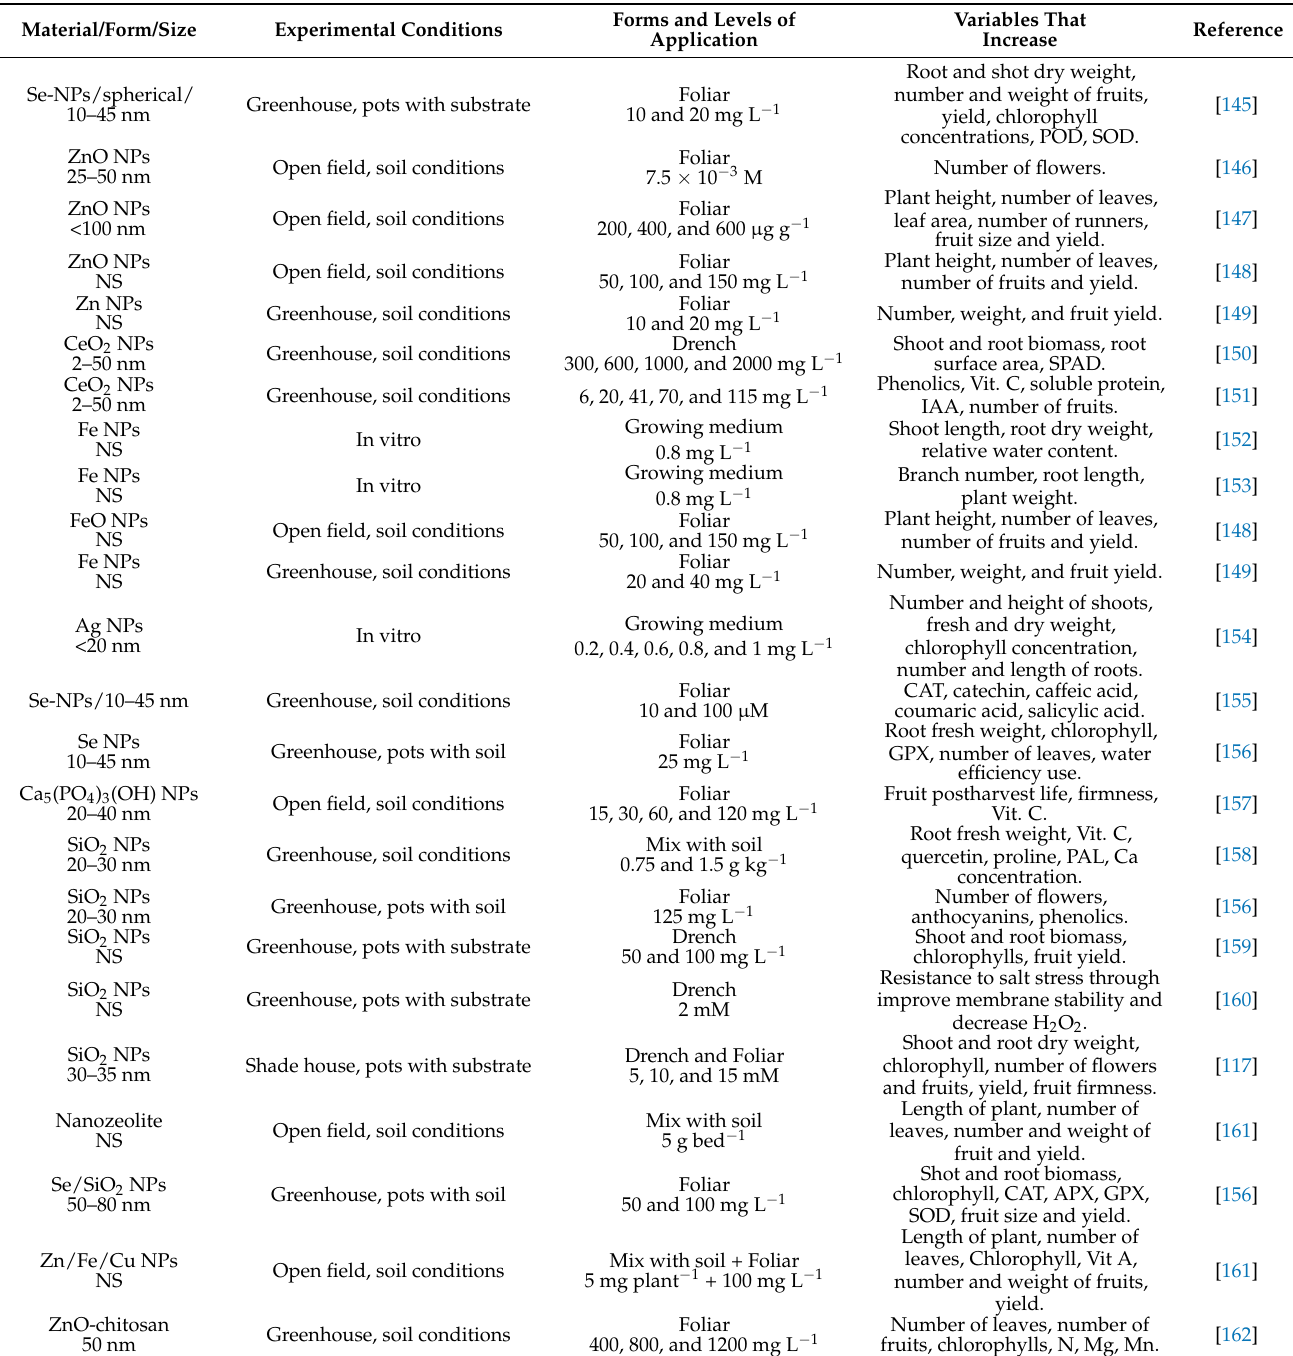
Table 6. Positive effects of NM applications on some growth or quality variables of strawberry